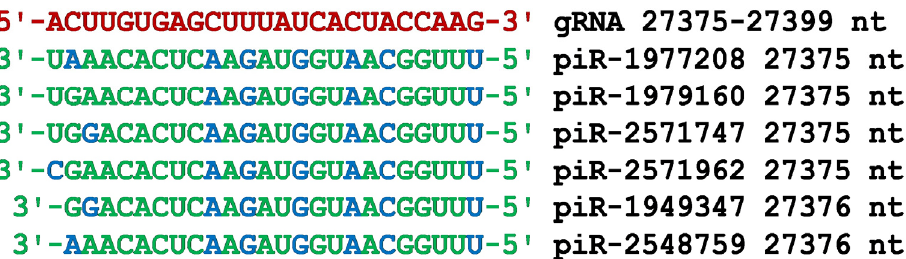
Figure 11. Nucleotide sequences of the six piRNA BSs cluster in the CDS of gRNA from 27,375 nt to 27,399 nt and the nucleotide sequences of piRNAs. Note: The piRNA nucleotides that form canonical pairs with gRNA are highlighted in green and non ‐ canonical pairs are highlighted in blue. The names of the piRNAs are followed by the beginning of their BSs.